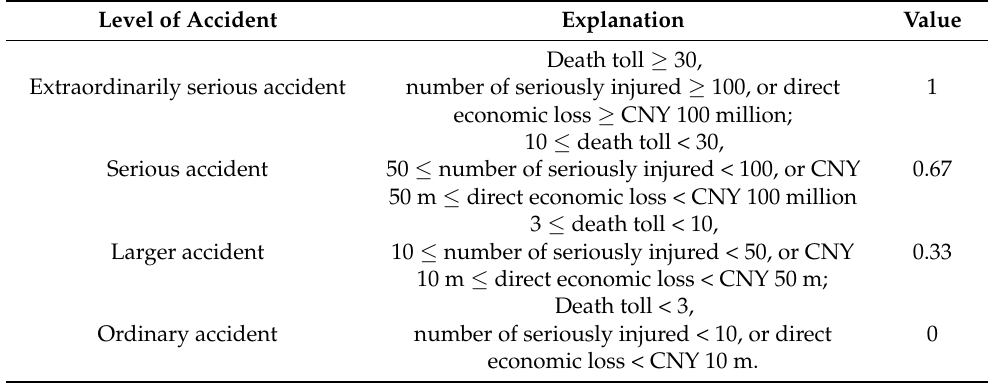
Table 2. Classification of safety accident